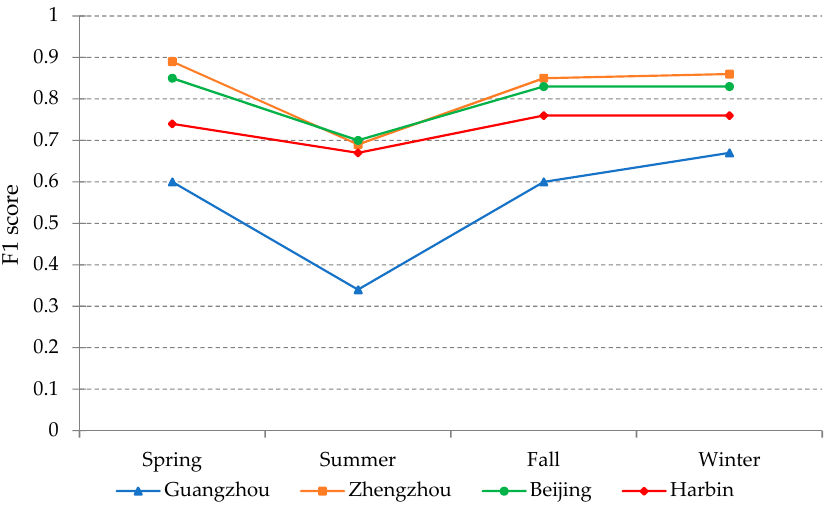
Figure 5. F1 scores of FCN models validated on different combinations of region and season. Each model is trained on the same combination as that of the validation.